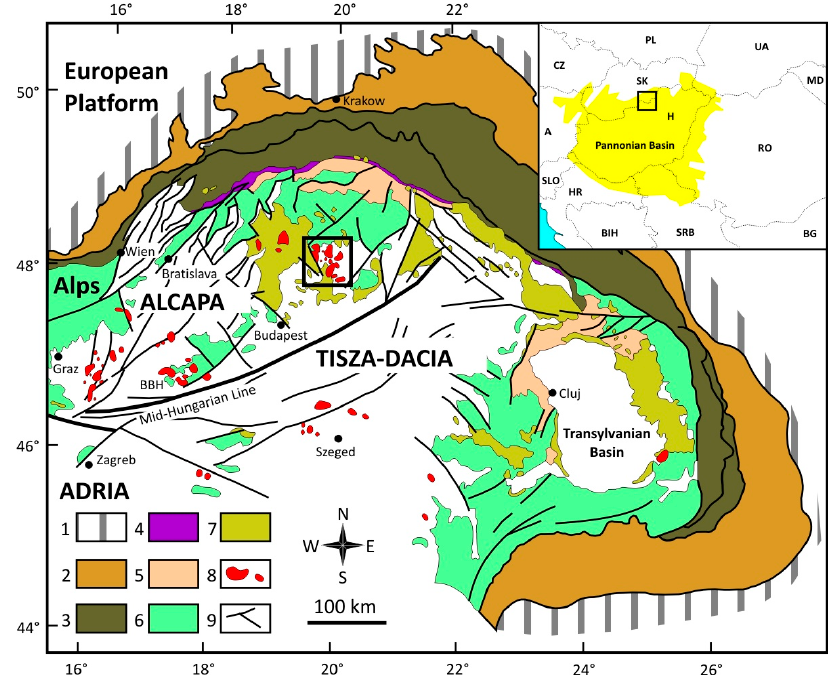
Figure 1. Schematic drawing of the Carpathian arc and the intra-Carpathian back-arc basin (Pannonian Basin) modified after [19]. Explanations: 1. European (W) and Skythian (E) platforms; 2. foredeep, 3. Tertiary accretionary wedge, 4. Klippen belt, 5. Palaeogene back-arc basin, 6. Variscan basement with pre-Tertiary sedimentary cover and Mesozoic nappe units (Cretaceous accretionary wedge), 7. Neogene andesites and rhyolites, 8. Upper Miocene–Quaternary alkali basalt, 9. Major normal, strike-slip, and thrust faults. Inset shows state boundaries. Rectangle marks the south-Slovakian volcanic province enlarged in Figure 2.